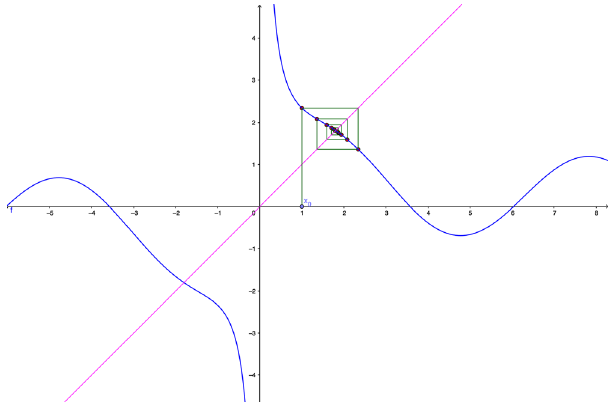
Figure 10: f t 1 μn ( ) → , for μ 1.5 = .